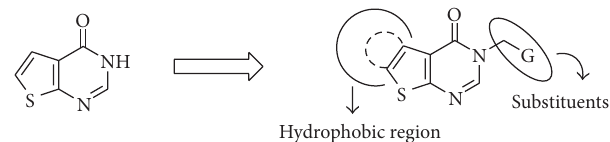
Figure 2: Design strategy for cycloalkylthieno[2,3- d ]pyrimidinone